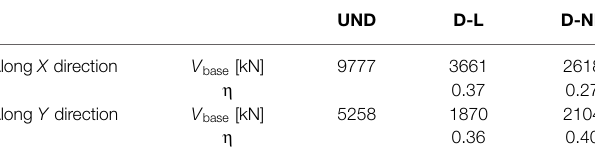
TABLE 3 | Reduction in the base shear (direct five-step procedure) .